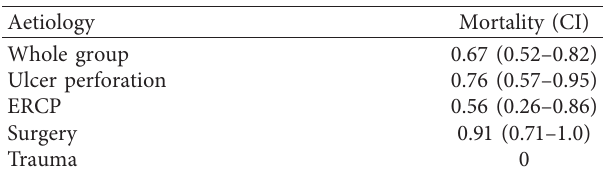
Table 5: The area under the receiver-operating characteristic curve (AUC) and 95% confidence interval of each aetiology of duodenal